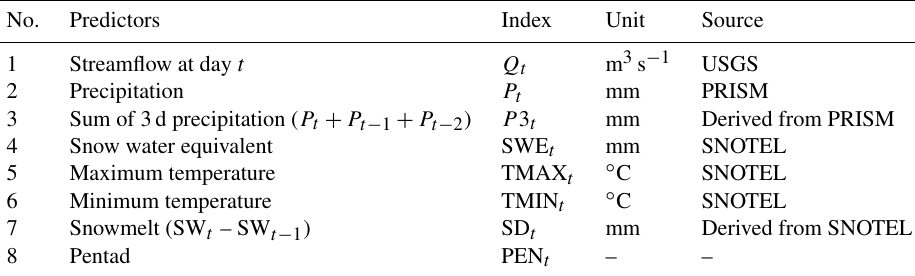
Table 2. List of predictors.